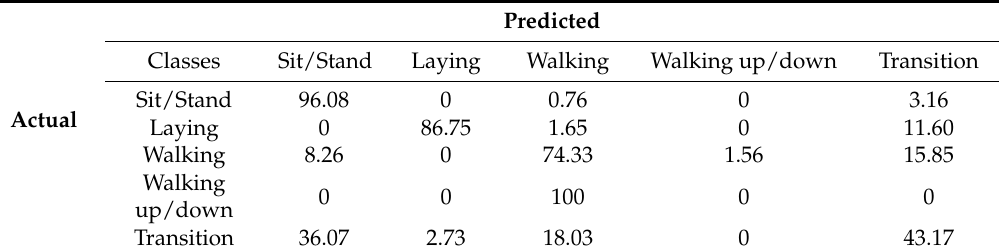
Table 2. Mean confusion matrix on the test set using the latest sensor